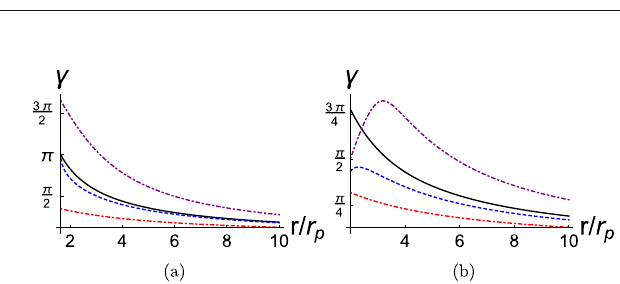
Table 2 The upper bound of the parameter β for different values